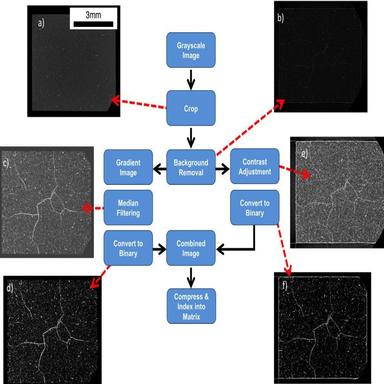
Image processing flowchart for 2D input image. (a) Cropped image with cropping defined within a few microns of the material boundary (see next figure for original image). (b) Image after applying a background removal algorithm. (c) Result of applying median filtering to the gradient image of the result of the background removal step. (d) Thresholded binary image from median filtering results. (e) Contrast adjusted version of background removed image. (f) Thresholded binary image from contrast adjusted image